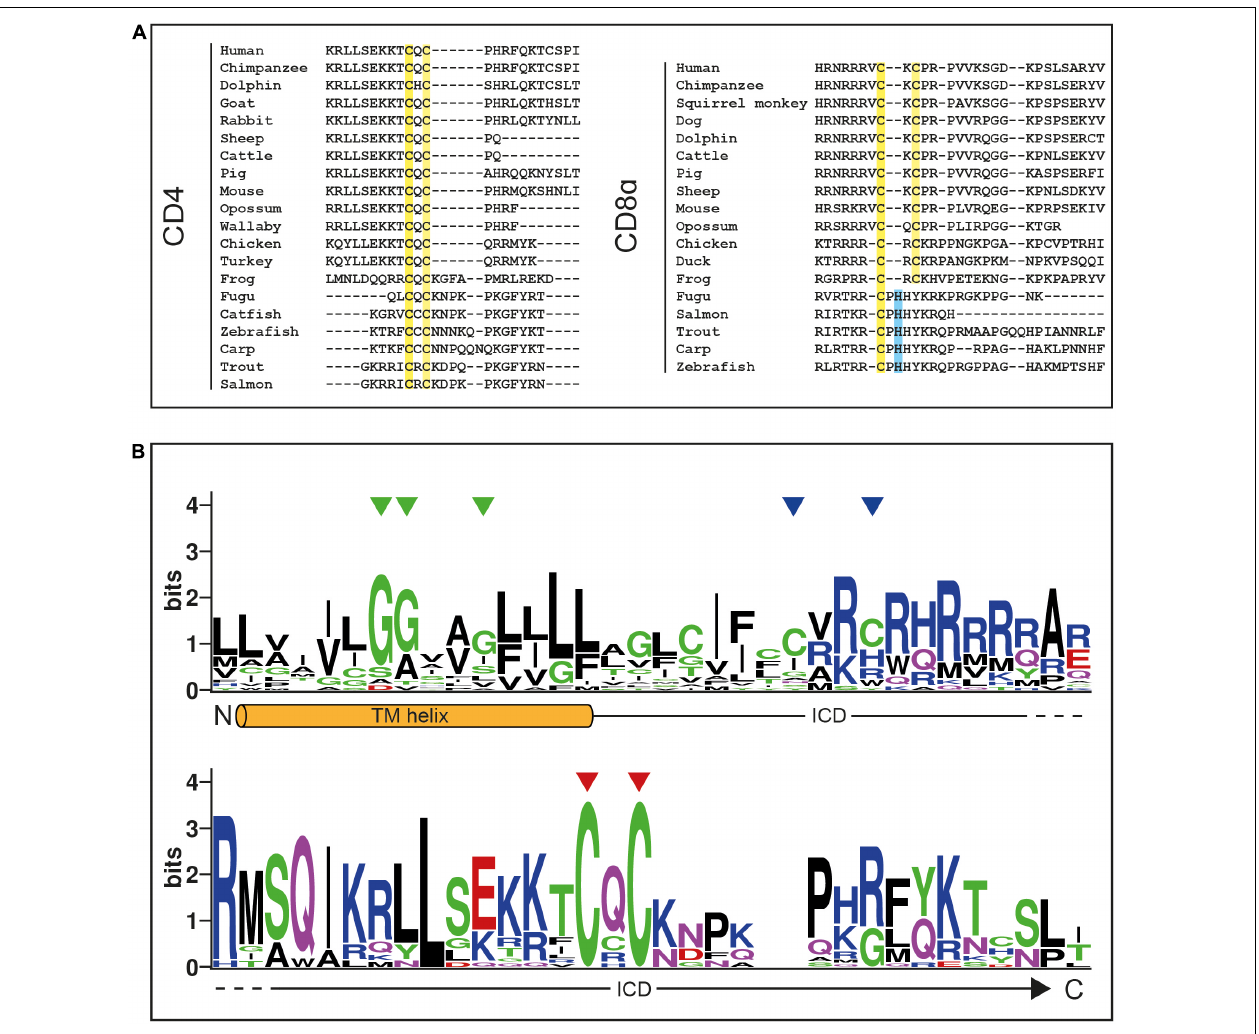
FIGURE 2 | The coreceptor “zinc clasp” is highly conserved. (A) MUSCLE alignment of C-terminal CD4 and CD8 α sequences with clasp cysteines highlighted in yellow and histidines in equivalent positions highlighted in blue. Adapted from Chida et al. (2011). (B) A sequence LOGO of the CD4 transmembrane (TM) helix and intracellular domain (ICD). Green triangles indicate glycines in the conserved GGXXG motif, blue triangles indicate S-palmitoylation sites, and red triangles indicate clasp cysteines. Sheep CD4 was excluded from this analysis due to the presence of large insertions in this regions bearing no homology to any other